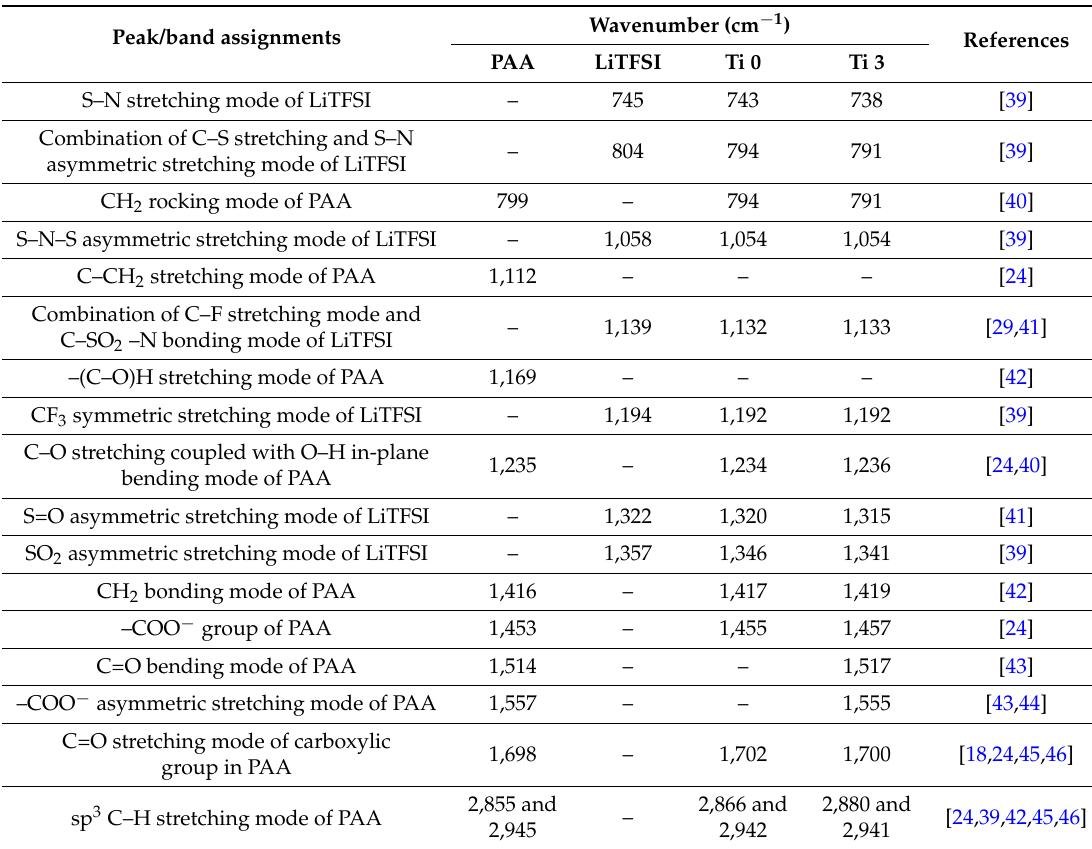
Figure 8. The proposed ion conduction mechanism in nanocomposite polymer electrolyte membranes. 4.2. Attenuated Total Reflectance—Fourier Transform Infrared (ATR-FTIR) The assignment of all possible peaks is listed in Table 2. Table 2. Peak assignments of PAA, LiTFSI, Ti 0 and Ti